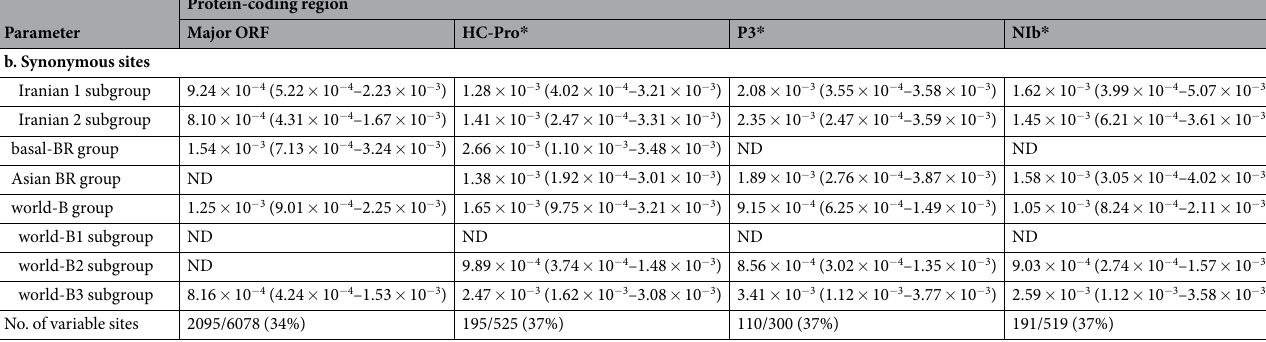
Table 1. Estimates of nucleotide substitution rate and time to the most recent common ancestor for turnip mosaic virus. a Complete major ORF (open reading frame) (polyprotein), HC-Pro * (partial helper-component proteinase), P3 * (partial protein 3) and NIb * (partial nuclear inclusion b) regions. b Time to the most recent common ancestor (years before 2012). c 95% credibility intervals in parentheses. d Not determined. The data set did not pass the date-randomization test. e Non-synonymous (dN) and synonymous (dS) substitution